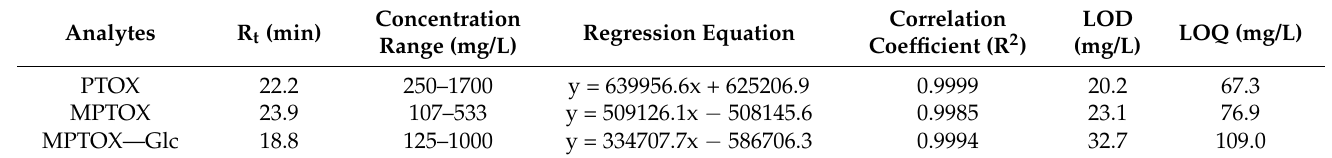
Table 1. HPLC calibration curve